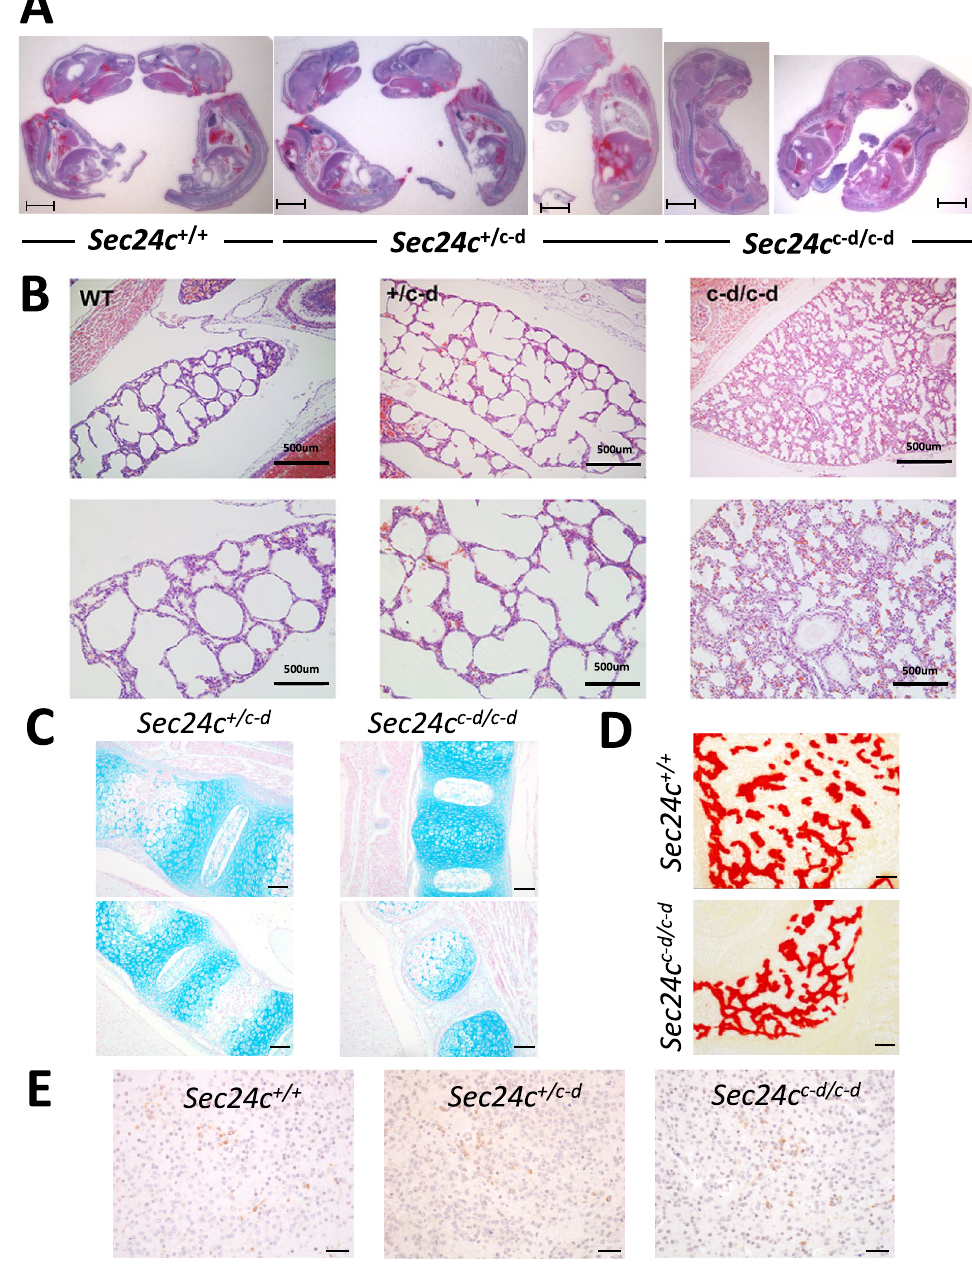
Figure 3. Histological assessment of Sec24c + /c-d intercross progeny at P0. ( A ) H&E stained longitudinal sections of P0 pups from Sec24c + /c-d intercross taken shortly after birth. A total of 16 animals were analyzed by H&E at this time point. Scale bars = 5 mm. ( B ) Low and higher magnification views of H&E stained sections through the lung of P0 mice collected shortly after birth. Analysis did not identify gross alterations in the morphology of the respiratory tree, although alveoli from Sec24c c-d/c-d pups were often uninflated and lined by columnar epithelium compared to the flattened epithelial lining wild type and Sec24c + /c-d alveoli. Lungs were fixed and sectioned in the context of the whole pup. Scale bars = 500 or 250 microns, as indicated. ( C ) Longitudinal sections through the vertebral column of Sec24c c-d/c-d embryos and wild type or Sec24c + /c-d controls illustrating regions of developing cartilage in forming vertebral bodies by Alcian blue (n = 3 for each genotype, Scale bars = 50 μm) and ( D ) alizarin red stains (n = 2 for each genotype). ( E ) Immunohistochemistry for SERT in Sec24c c-d/c-d and wild type control brain tissues (n = 3 per genotype). Scale bars = 20